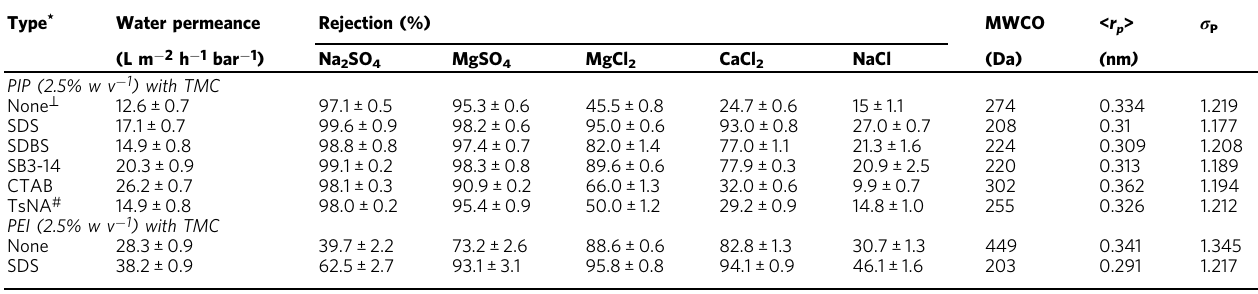
Table 1 Water permeance, rejection of selected salts, MWCO, and pore size distribution for different NF membranes. Type * Water permeance